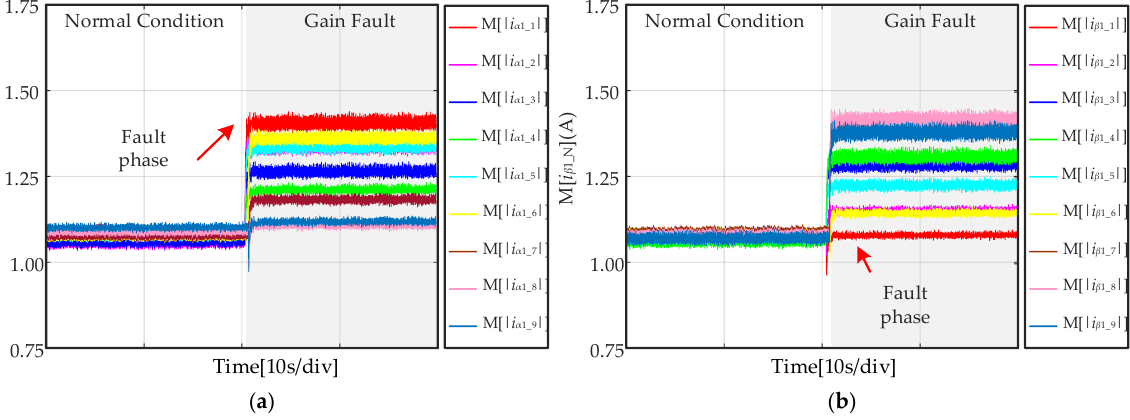
Figure 11. ( a ) D N in loss signal fault; ( b ) M[ i q 1_ m ] and i q 1_ N in loss signal fault.